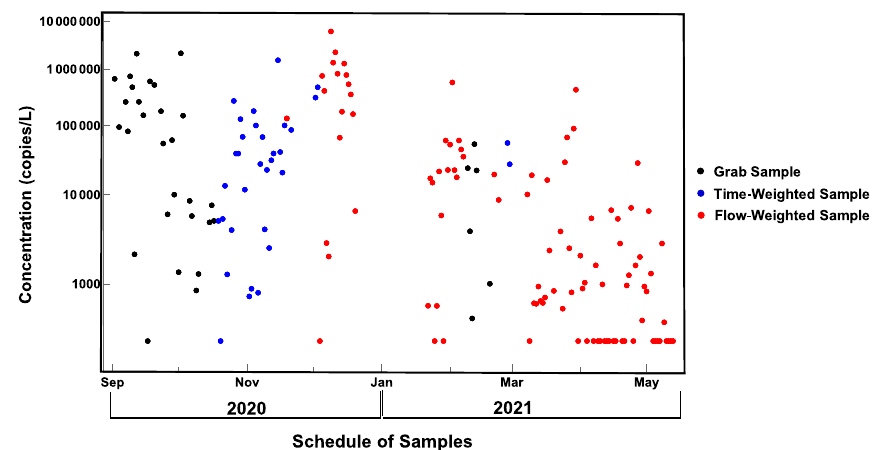
Fig. 8 Actual SARS-CoV-2 concentration for sample population using different sample collection